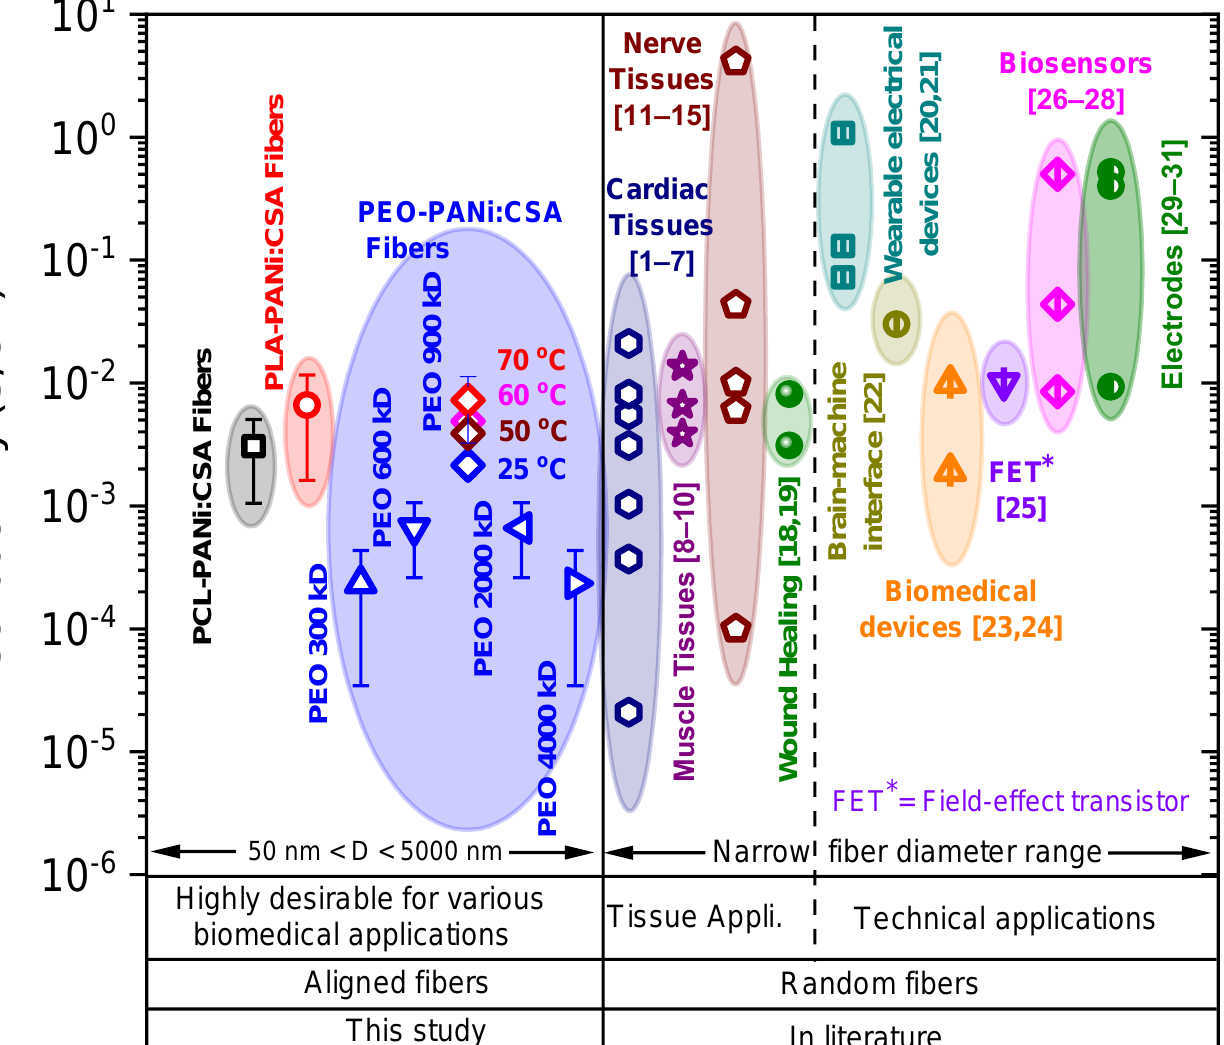
Figure 10. The comparison of conductivities of conductive fibers in this study (PEO-PANi:CSA fibers, PCL-PANi:CSA fibers, and PLA-PANi:CSA fibers) and stated in the literature for various tissue and technical applications. The PEO-PANi:CSA fibers contain conductive fibers for different molar masses of PEO (300 – 4000) kD. The PEO (900 kD)-PANi:CSA fibers were annealed at 50, 60, and 70 °C for 24 h.